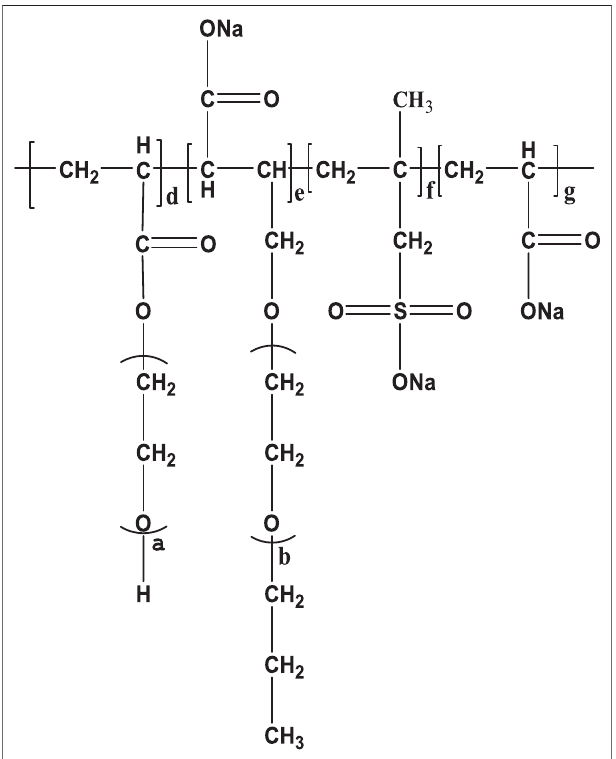
FIGURE 4 | Structure of synthesized ordinary polycarboxylate